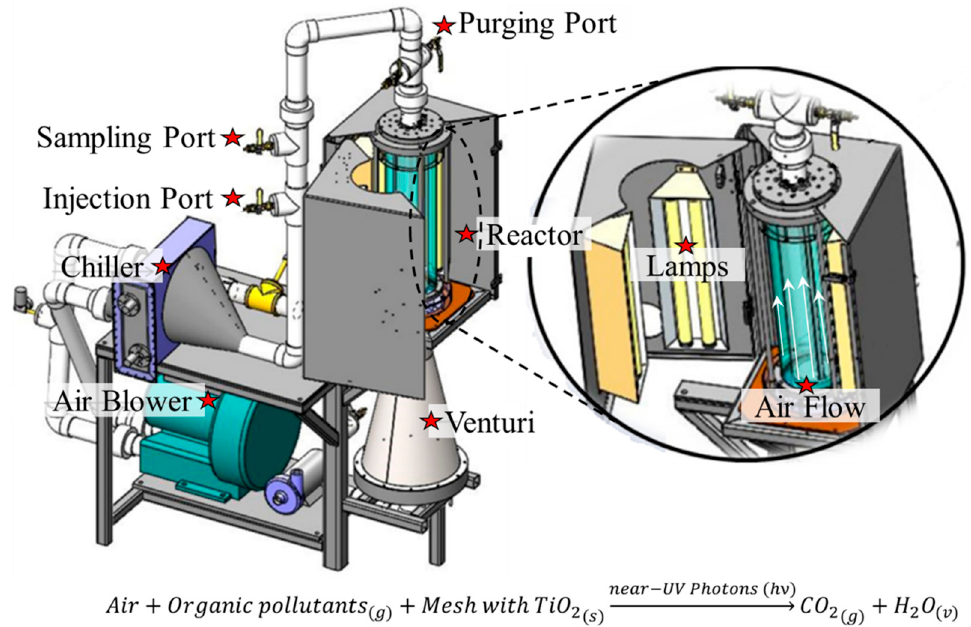
Figure 6. Schematic description of the current version of the Photo-CREC-Air Reactor (PCAR) with an annular mesh-coated Venturi-reactor section.